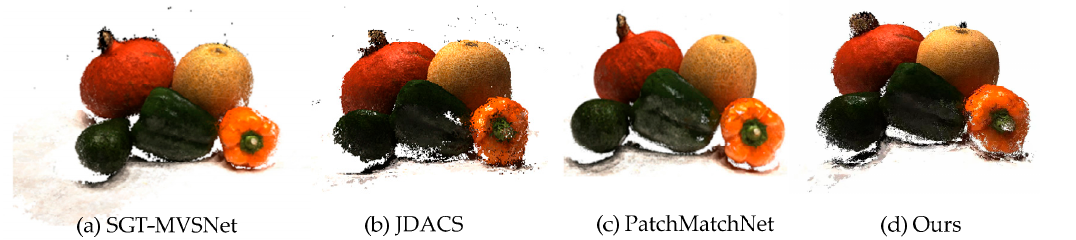
Figure 5. Comparative experiment of the effects of four networks: ( a ) semi ‐ supervised rendering; ( b ) unsupervised rendering; ( c ) supervised rendering; ( d ) our rendering.